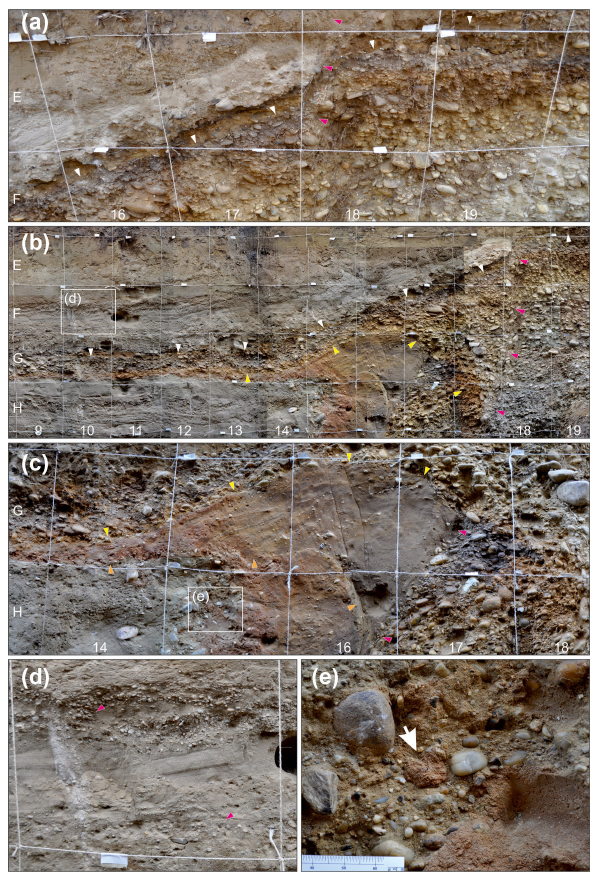
Figure 6. Details from the SW-facing wall of the trench SDF1. (a) Evidence for earthquake A1 from the displacement of a marker horizon (white arrows), which is correlated across the fault (red ar- rows). (b) Evidence for earthquake A2 from a colluvial wedge com- posed of sandy gravel overlying a tension gash filled with the same material. Top and base of the wedge are marked by white and yellow arrows, respectively. To the right the wedge abuts against fault 1 (red arrows). (c) Colluvial wedge associated with earthquake A3 overly- ing a tension gash adjacent to fault 2 (yellow and orange arrows: top and base of the wedge or tension gash; red arrows: fault). Sev- eral deformation bands that branch from fault 2 and formed during a later earthquake cut the wedge. It overlies wedge 4, which equally contains reddish redeposited soil. Wedge 4 shows an erosional con- tact to grey high-stage flood sediments (around panel e ). (d) Defor- mation bands offsetting laminated fluvial sand (red arrows) above wedge 2. The deformation bands are correlated to the event horizon of E1 (detail of picture b ). (d) Detail of panel (c) . Erosional contact of wedge 4 to flood sediments. Armoured mudballs (arrow) derive from the eroded colluvium. dipping MF. The fault zone includes two parallel steeply dip- ping faults F1 and F2, with F2 reaching almost the present- day surface (see Figs. 5 and